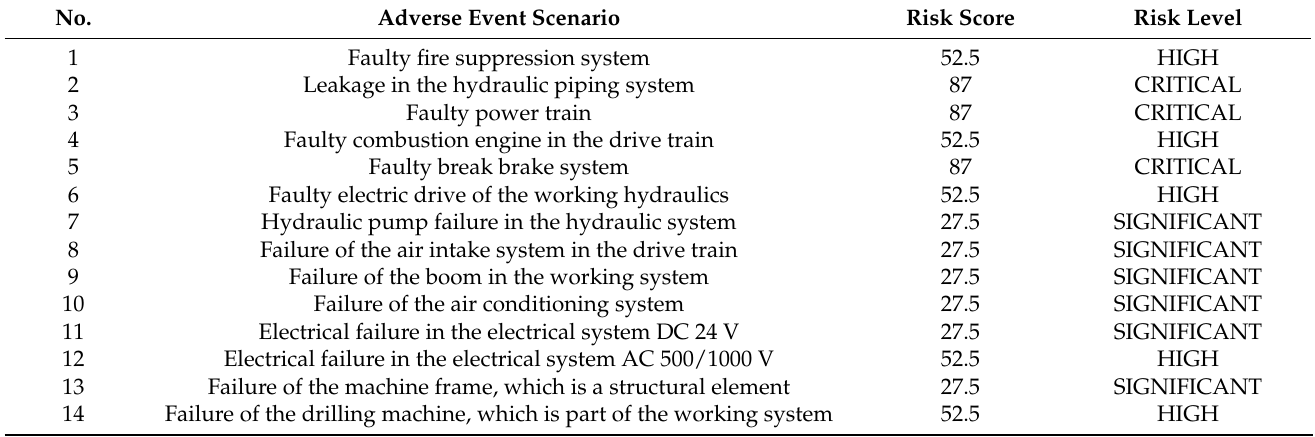
Figure 10. Structure of the proposed fuzzy model. Table 9. The risk score and risk level of identified adverse event Table 8. Parameters linguistic scores for all identified adverse event scenarios, based on experts’ opinions.